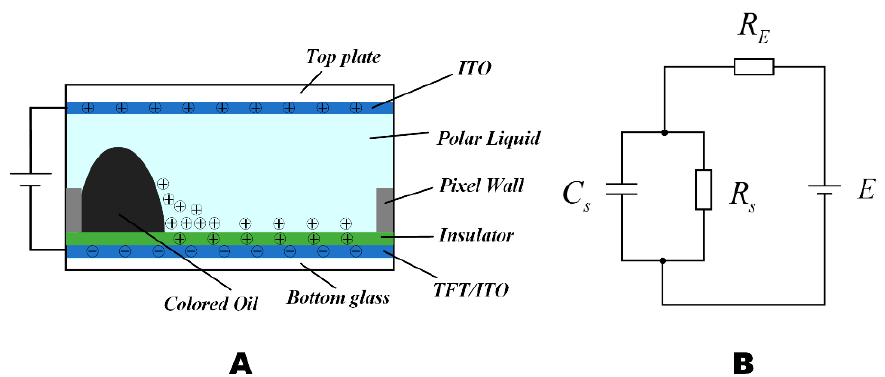
Figure 1. The EWD structure and its simplified equivalent circuit diagram. ( A ) Side view of EWD pixel structure under an electric field. ( B ) A simplified equivalent RC circuit model of EWD pixels.